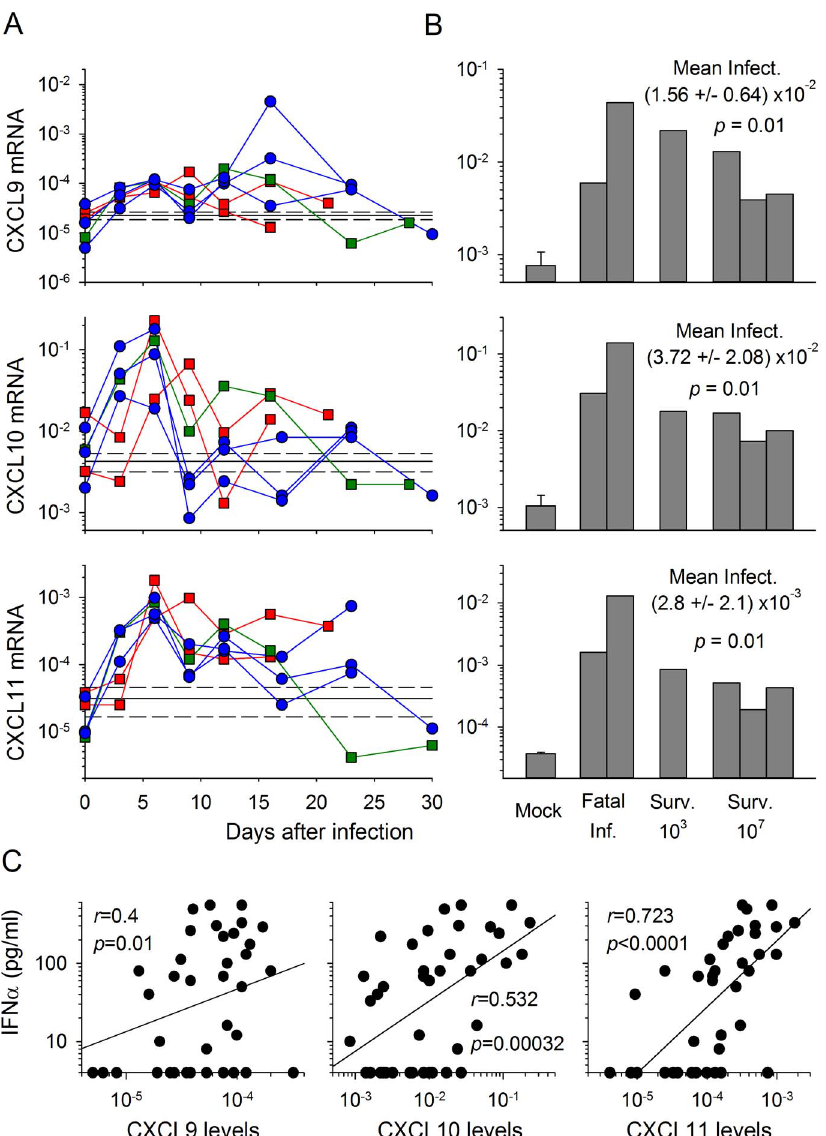
Figure 6. Production of CXC chemokine mRNA in PBMC and lymph nodes from LASV-infected cynomolgus monkeys. (A) The synthesis of CXC chemokine mRNA was assessed by RT-qPCR, with normalization against b -actin mRNA in PBMC obtained from fatally infected monkeys (red squares), the low dose-infected survivor (green squares) and the high dose-infected survivors (blue circles), at various times after infection. The mRNA levels in the two mock-infected animals are represented as the mean (solid line) 6 SE (hashed line) of the values obtained throughout follow-up ( n= 14). (B) The production of these mRNAs was also quantified in lymph nodes obtained 9 days after infection. The levels of mRNA are represented as the mean 6 SE of 4 samples for mock-infected animals (two animals, lymph nodes obtained 9 days after infection and at necropsy) and as individual values for the two fatally infected monkeys (fatal inf.), the low dose (10 3 FFU)-infected survivor and the three high dose (10 7 FFU)-infected survivors. The mean value 6 SE for all infected animals is shown, together with the significant difference between mock- and LASV-infected animals. C) Correlation between CXCL9, CXCL10 and CXCL11 mRNA levels in PBMC and type I IFN levels in plasma during the course of LASV infection in cynomolgus monkeys, represented by a linear regression with a correlation coefficient r and a probability of correlation p